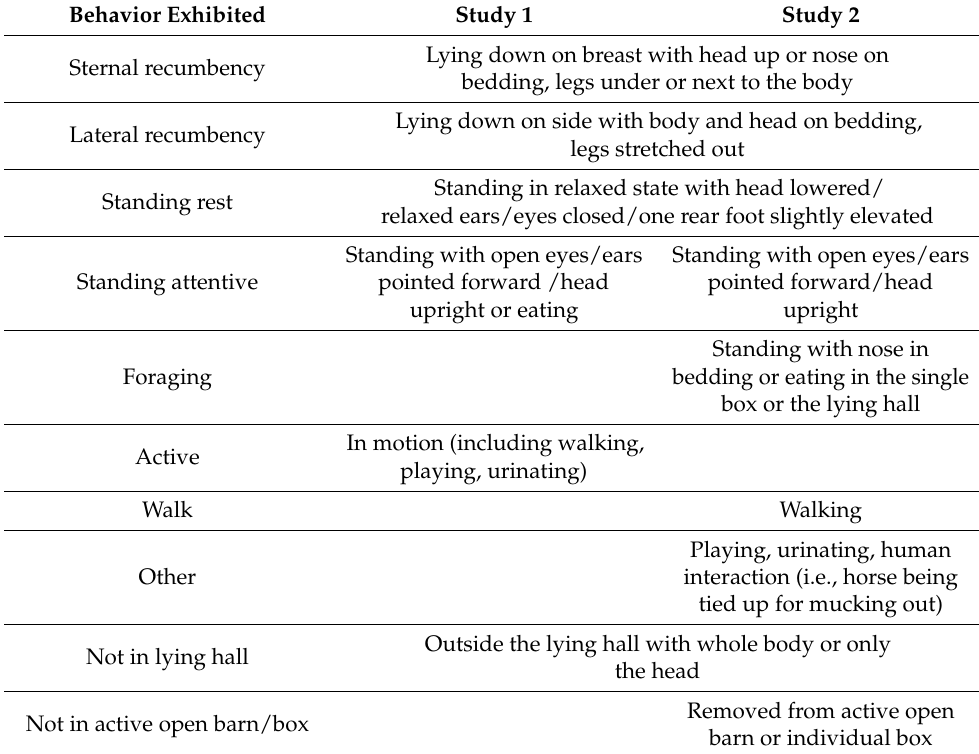
Figure 2. Illustration of the two methods used in the data collection for Study 1. The grey horses ( n = 5) were used in method 1 (interval registrations each minute) and all horses ( n = 18) were used in method 2 (scan sampling every hour). Table 1. Ethogram of behaviors exhibited and recorded during video observation in Study 1. Most behaviors were the same in Study 2, but some were divided into two categories.